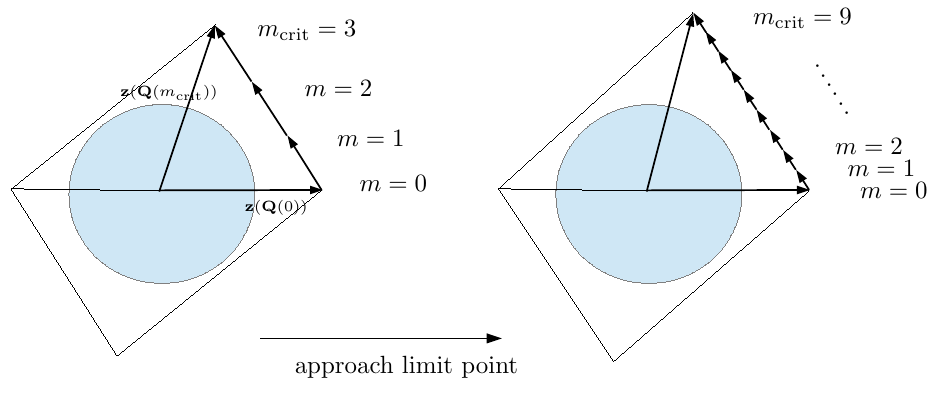
Figure 2 . Depiction of the convex hull spanned by the vectors (cid:6) z ( Q (0)) and (cid:6) z ( Q ( m crit )), which correspond to the lowest and highest instanton in our tower respectively. Note that we explicitly depicted the steps that we go through as we move up in this tower of instantons. As we move further along the in(cid:12)nite distance limit, we (cid:12)nd that these steps become smaller and smaller, which is compensated by the fact that our tower of instantons is becoming larger, such that the total length of this side of the convex hull remains (cid:12)nite and thus that the convex hull will always contain a ball of (cid:12)nite